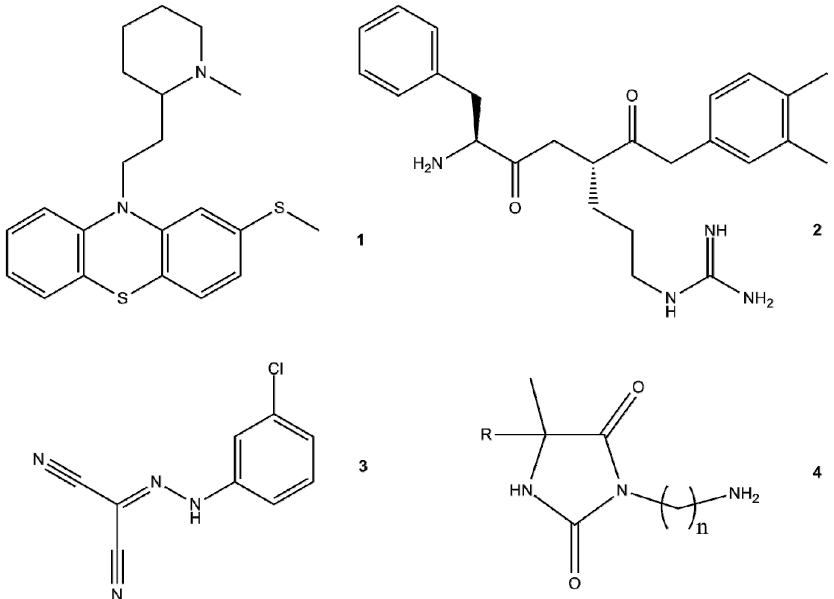
Figure 4. Examples of synthetic EPI compounds. ( 1 ) Thioridazine; ( 2 ) Phenylalanine-arginine β -naphthylamide (PA β N); ( 3 ) carbonyl cyanide 3-chlorophenylhydrazone (CCCP); ( 4 ) general structure of EPI hydantoins.